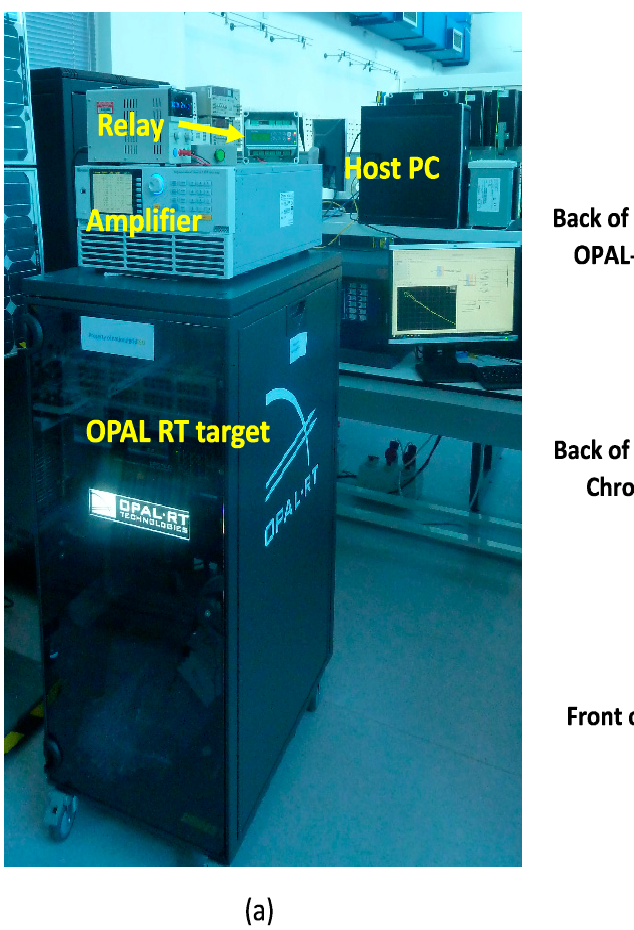
Figure 10. ( a ) HIL laboratory set up at Brunel University London. ( b ) The connection of the compo- nents: host PC, OPAL-RT target, amplifier Chroma 61,607, and LoM relay.